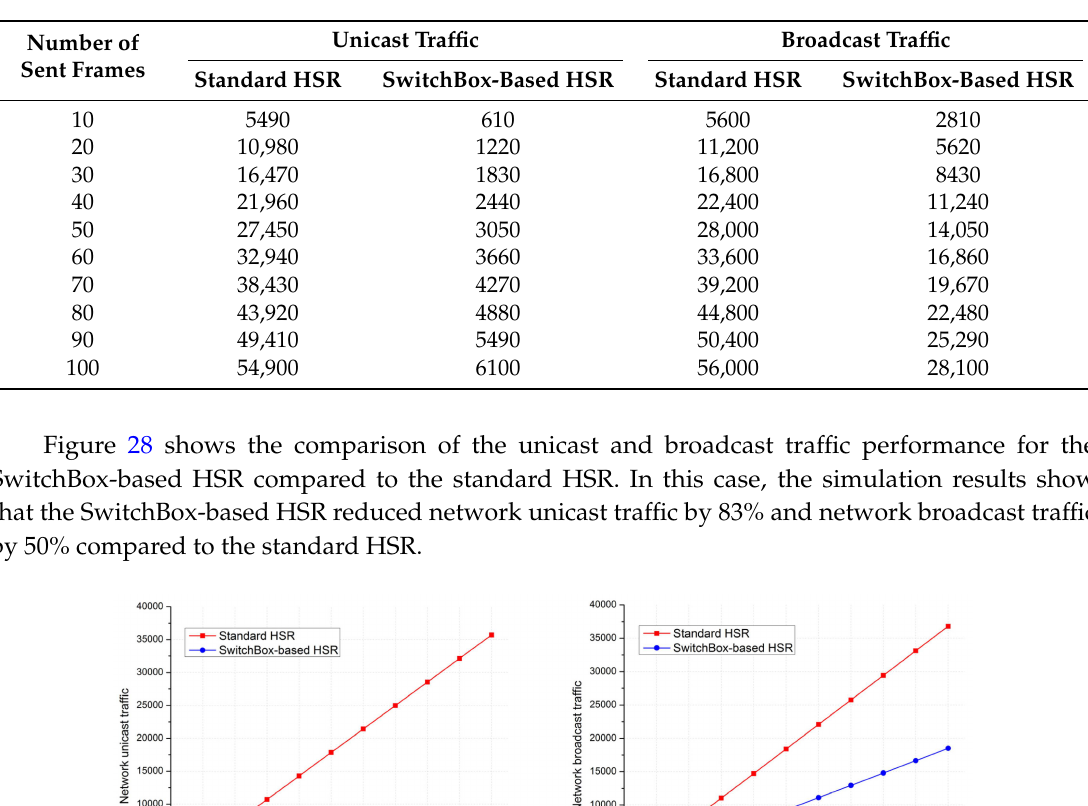
Table 5. Network traffic frames in case 2 of Simulation 3.